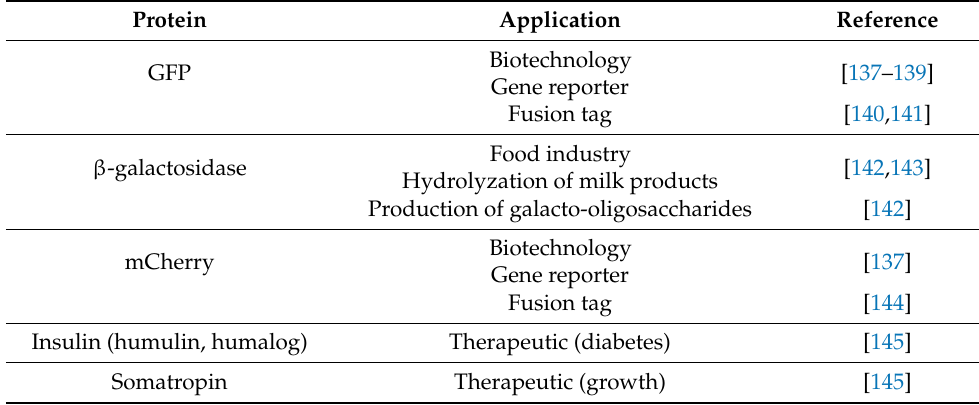
Table 7. Recombinant proteins produced by biotechnological processes.